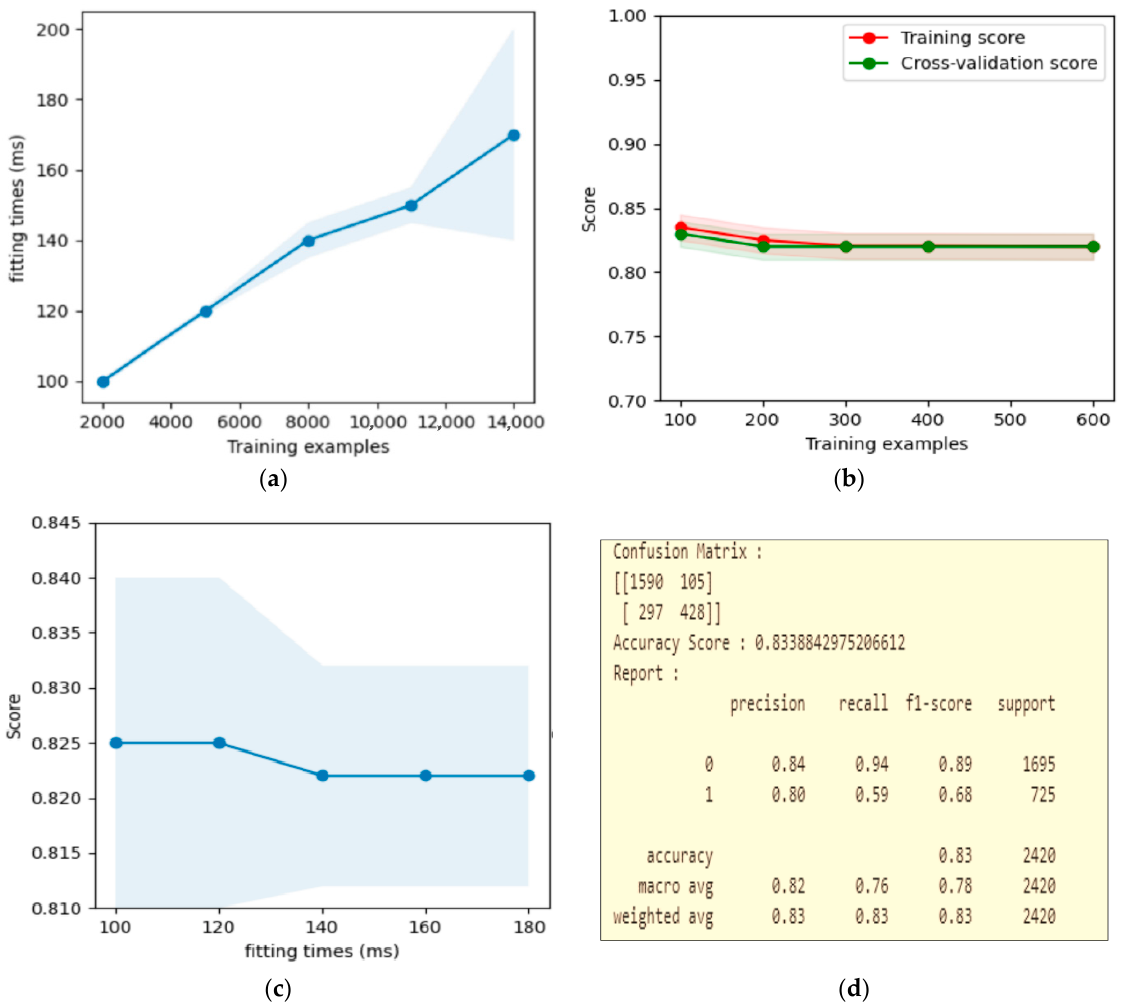
Figure 7. Final Ensemble model (Adaboost)—Scalability ( a ), Learning Curve ( b ) on Training examples, Performance Curve ( c ), and Evaluation metrics ( d ).